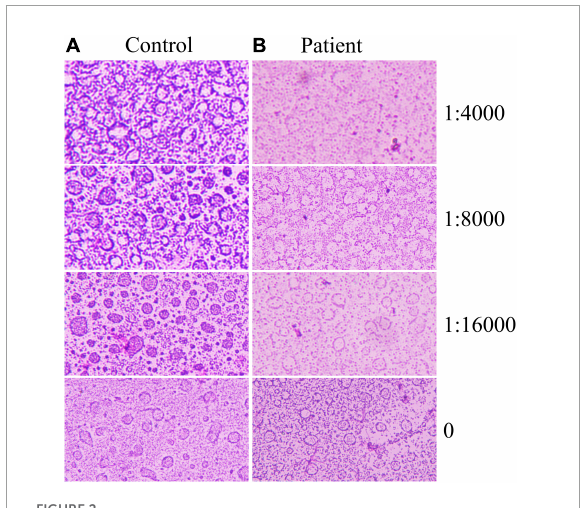
FIGURE2 Platelet complement reaction. Trastuzumab was diluted 16,000, 8,000, and 4,000 times, and different samples of platelets reacted with biological complement. (A) Trastuzumab-treated controls without acute hemolysis. (B) Trastuzumab in patients with acute hemolysis.